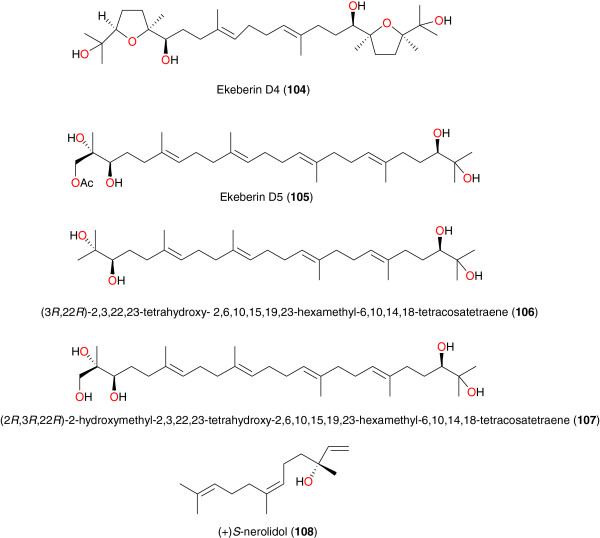
Anti-malarial acyclic triterpenes from African medicinal plants.